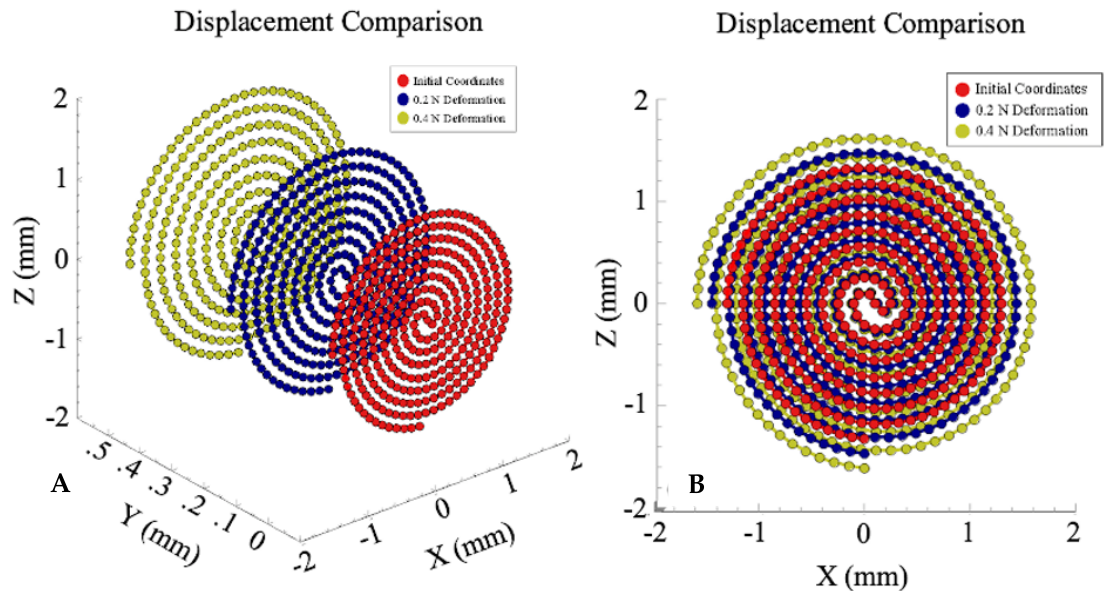
Figure 4. ( A ) The initial and deformation after 0.2 and 0.4 N channel coordinates are plotted above. The channel experienced an average Y displacement of 0.271 mm and 0.542 for the 0.2 and 0.4 N cases, respectively. ( B ) The zx-plane view of ( A ). The change in length of the channel is subtle near the center of the sensor but becomes more pronounced as the channel expands distally. The total length change for the 0.2 and 0.4 N cases is 4.48 and 8.97 mm, respectively. The change in resistance for each case was calculated for all line segments that formed the spiral channel using Pouillet’s Law. The final resistance of the sensor was calculated for each case and can be seen in Figure 5, plotted against its respective force value. The maximum resistance increase was 1.5 ohms in the 0.4 N case. Using a linear model, the resistance increased approximately by 0.37 ohms/0.1 N. The analytical solution of the sen- sor modeled as a neo-Hookean material is also shown in Figure 5a. A neo-Hookean model was used to analytically determine the sensor’s change in electrical resistance in response to an increasing channel length. Using a model suitable for uniaxial compression of an incompressible solid, a relationship between the resistance after deformation and length of the channel was found (see Equation (8)). Using the initial resistance of the proposed geometry, the theoretical resistances across channel lengths of 35–50 mm were calculated while maintaining a constant initial length of 37.4 mm. The resulting resistances and their respective channel lengths from the force sweep in Section 3.1 were overlaid onto the theoretical resistance values previously mentioned above. The resistance vs. length trends for both models can be seen in Figure 5b.